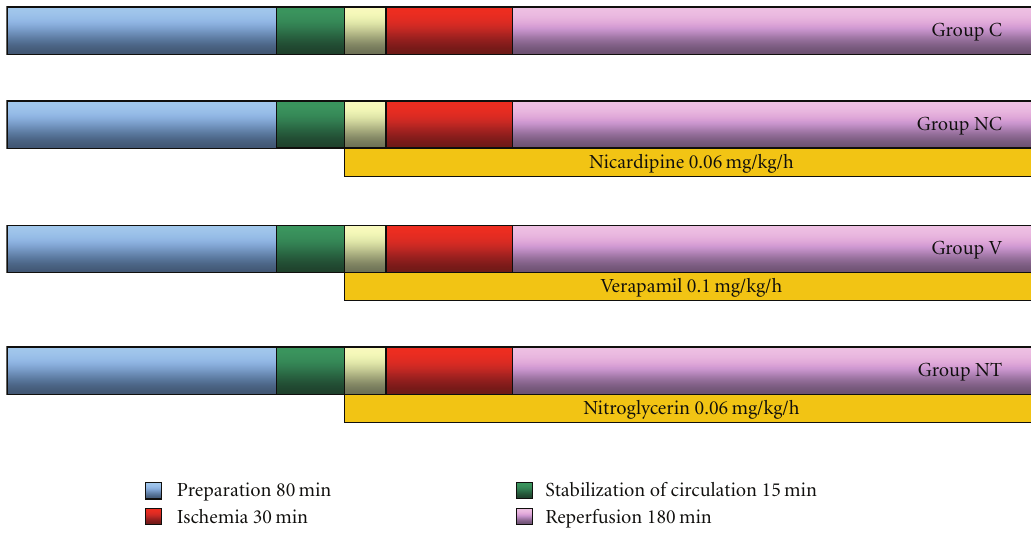
Figure 1: Schematic diagram of the protocol. Group C: a control group ( n = 9). Group NC: a nicardipine group ( n = 5). Group V: a verapamil group ( n = 8). Group NT: a nitroglycerin group ( n =